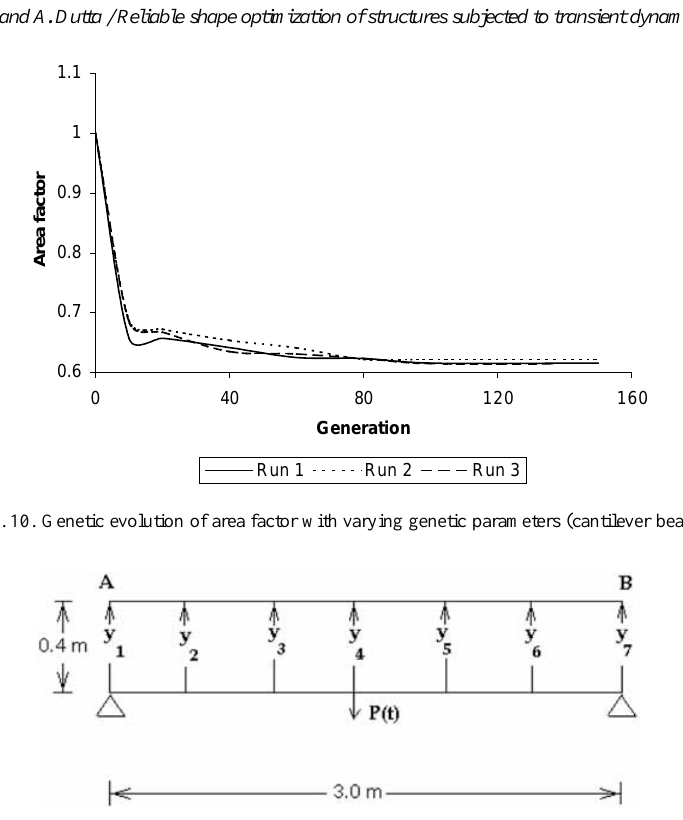
Fig. 11. Simply supported beam with B-spline boundary (AB), geometry, boundary conditions, loading and prescribed variables.